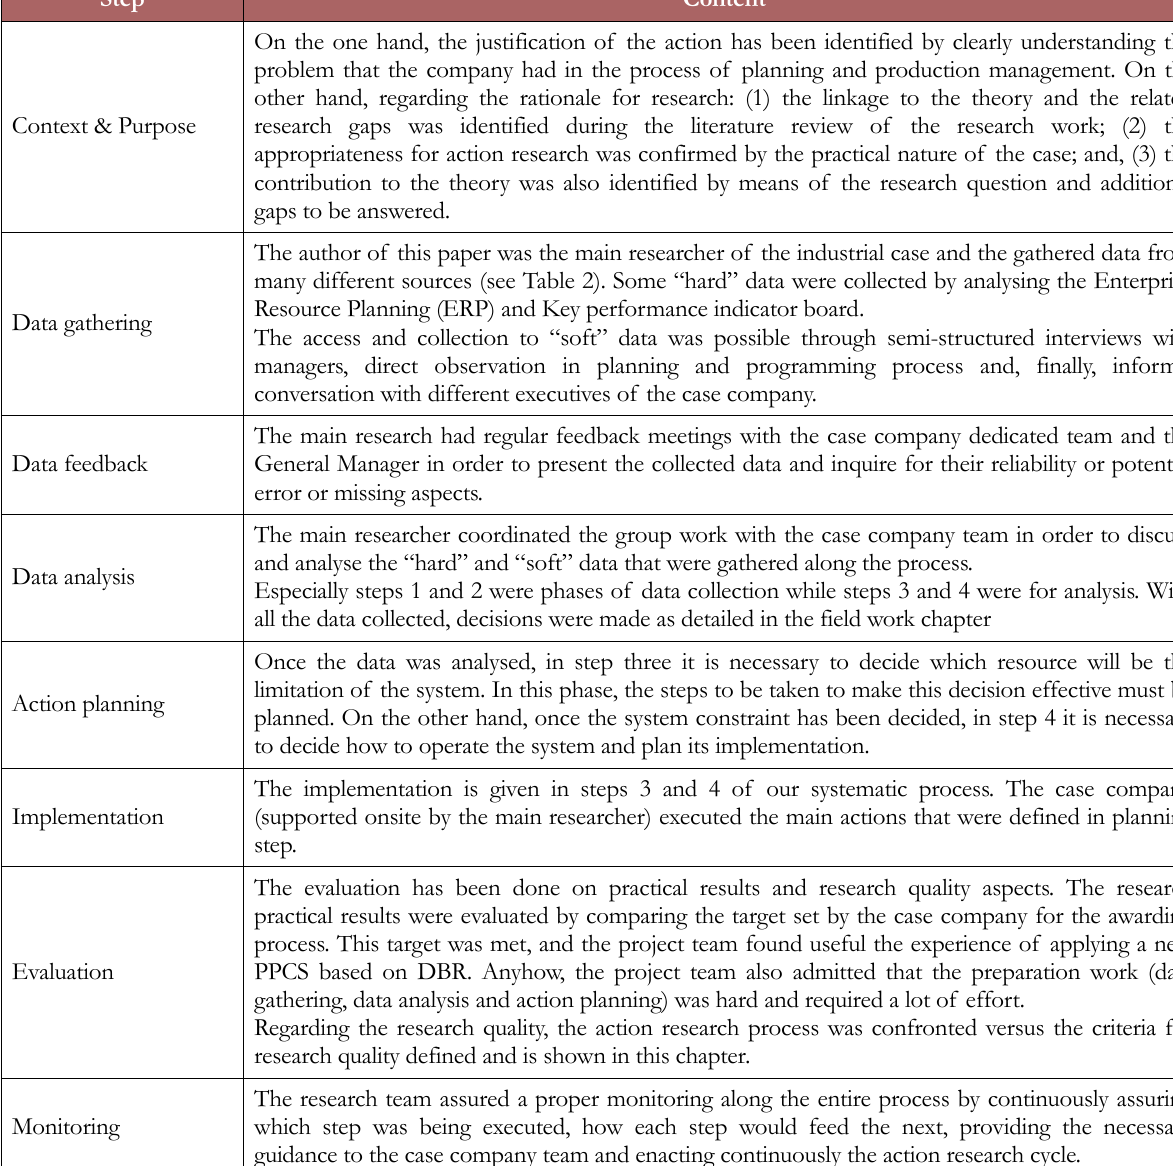
Table 9. Content of the eights steps of the action research process (Coughlan & Coghlan,